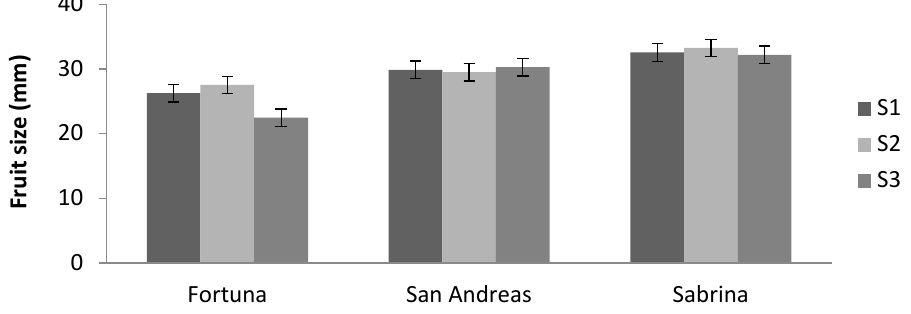
Figure 3. Mean values of fruit size of the total yield for three strawberry cultivars (Fortuna, San Andreas and Sabrina) irrigated with three nutrient solutions. K:N balance: S1 (1.3/2.0), S2 (2.6/1.0), S3 (3.0/0.6) in growth and productive period. Vertical bars indicate LSD value ( p < 0.05).